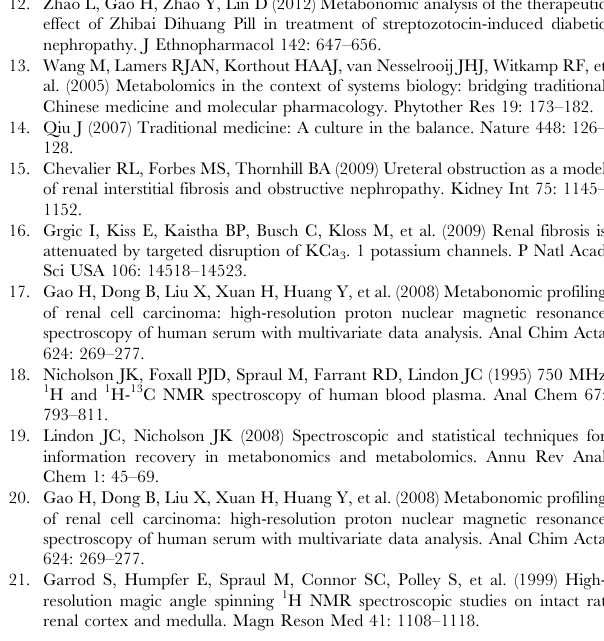
Figure S1 Representative HE-stained sections (200 fold) of kidneys from UUO (A), CAO doses of 100 mg/kg (B),